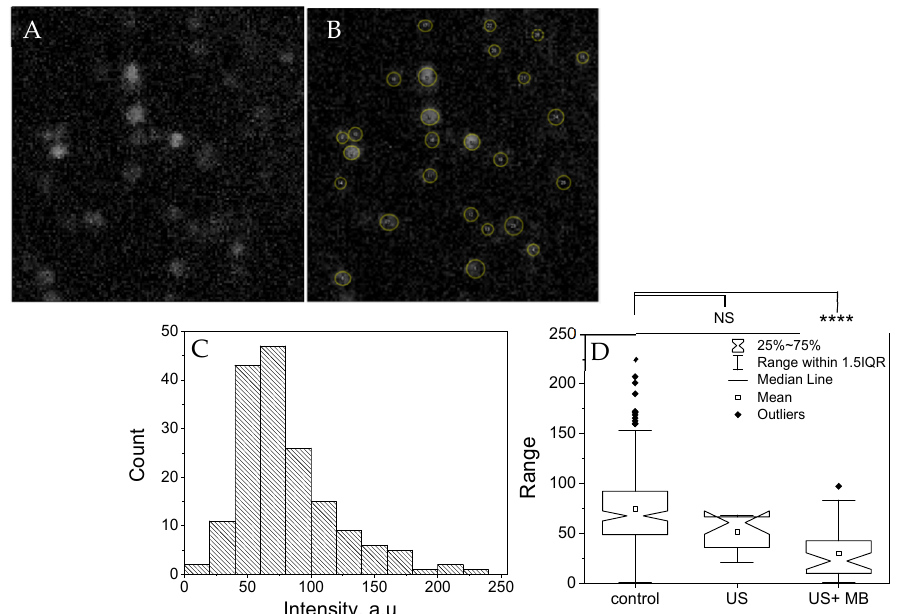
Figure 7. Sonoporation of cells insonicated in the setup. ( A ) An example of the acquired ultrafast images; ( B ) segmentation of cells within the fluorescence microscopy image; ( C ) Calcein-AM fluorescence distribution in the control cell group; ( D ) Notched boxplots compares the fluorescence intensity distribution of the control and the two experimental groups (US; US + MB); **** corresponds to p < 0.0001.